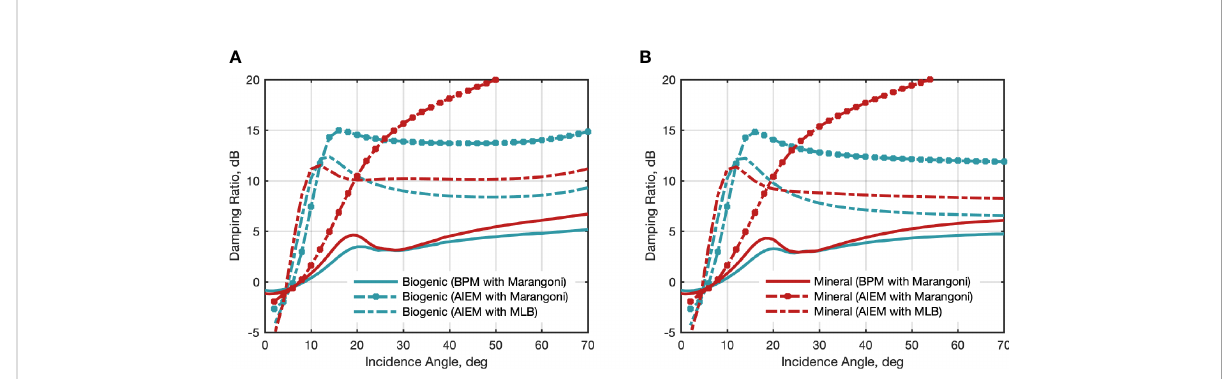
FIGURE 3 X-band BPM and AIEM predicted DR at HH (A) and VV (B) polarization versus incidence angle. BPM and AIEM predictions are shown in continuous and dashed lines, respectively. The rheological parameters refer to a biogenic slick (blue lines) and a mineral oil slick (red lines). The effect of the surfactant is included using Marangoni damping y Mar for BPM. While for AIEM, the effect of slicks is included by Marangoni damping y y Mar and MLB damping MLB ,